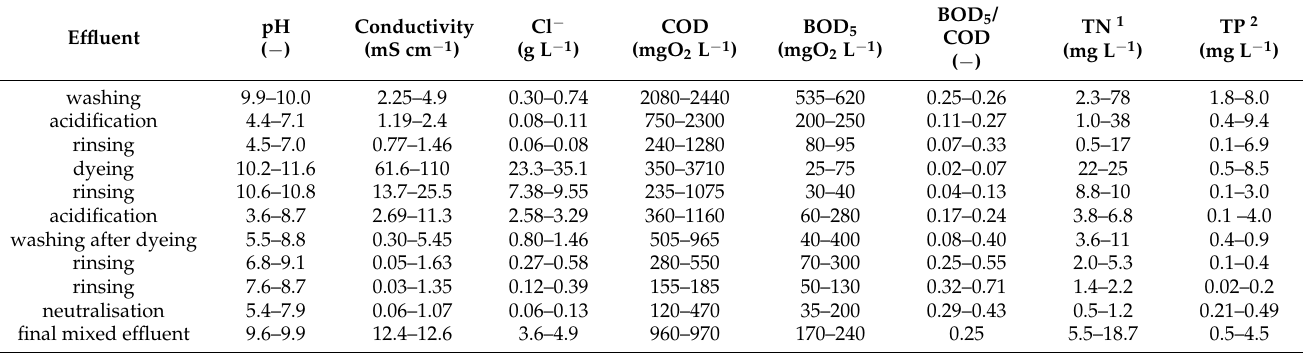
Table 1. Typical parameters of wastewater streams generated during reactive dyeing of cotton